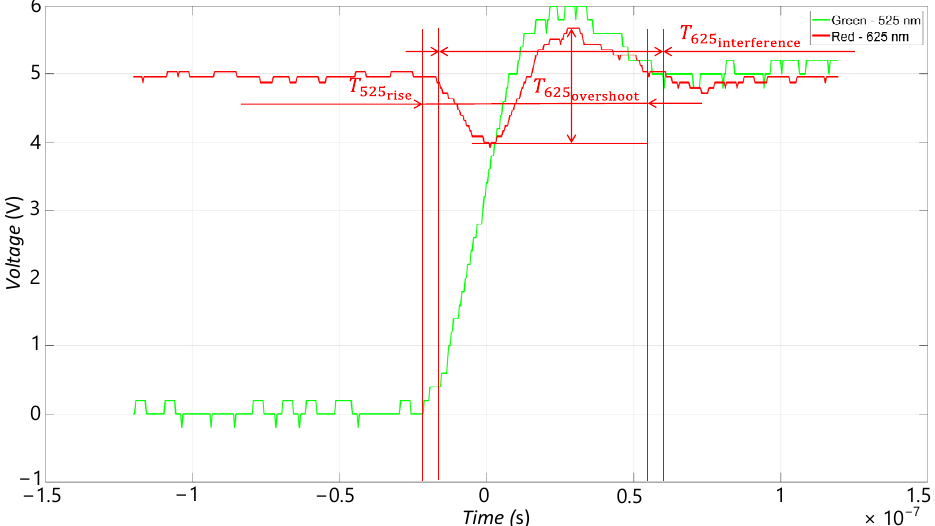
Figure 15. Recorded transients when the LEDs with a wavelength of 525 nm were switched off and the LEDs with a wavelength of 625 nm remained switched off.